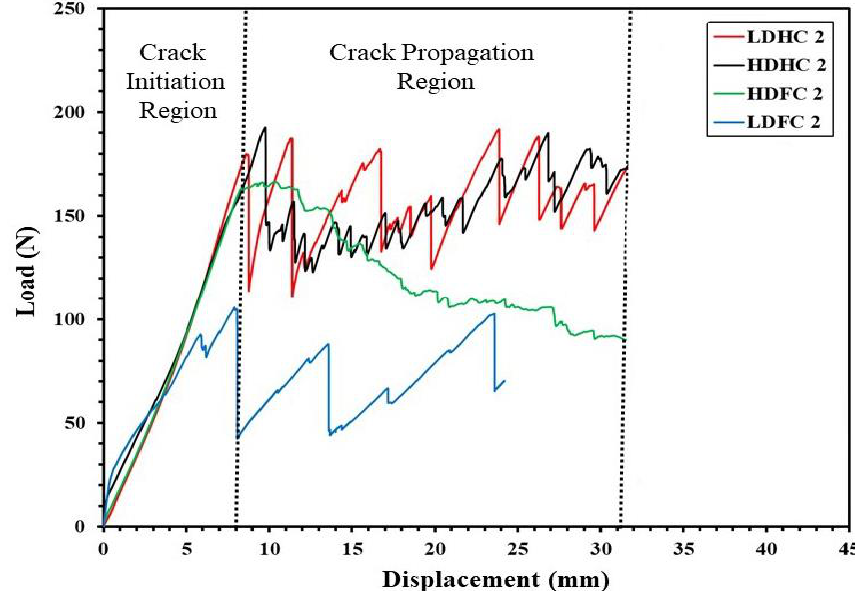
Figure 11. Load versus displacement response of 4 sandwich systems under Mode-I loading.